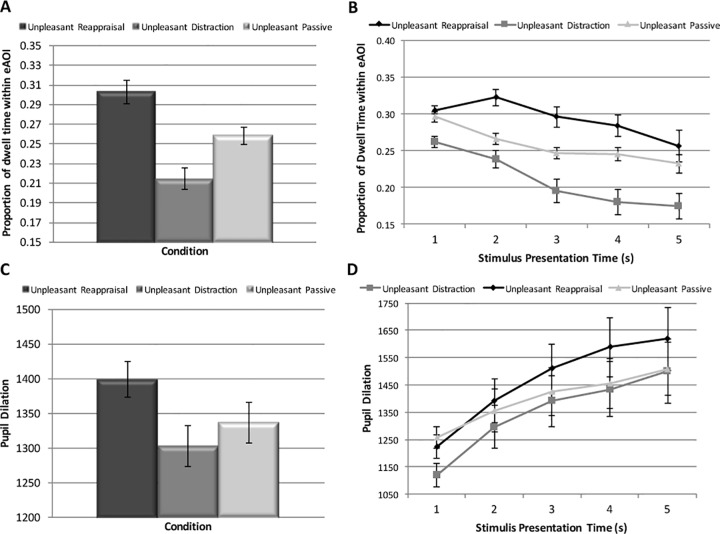
Mean Proportion Dwell Time and Pupil Dilation within the Emotional Areas of Interest.A) Mean (SE) proportion dwell time to the emotional interest areas for each condition, collapsing across the entire 5 second period; B) Mean (SE) proportion dwell time to the emotional interest areas for each condition, averaged at separate 5 second intervals; C) Mean (SE) pupil dilation at fixation within the emotional areas of interest across the entire 5 second period; D) Mean (SE) pupil dilation at fixation within the emotional areas of interest, averaged across separate 5 second intervals.